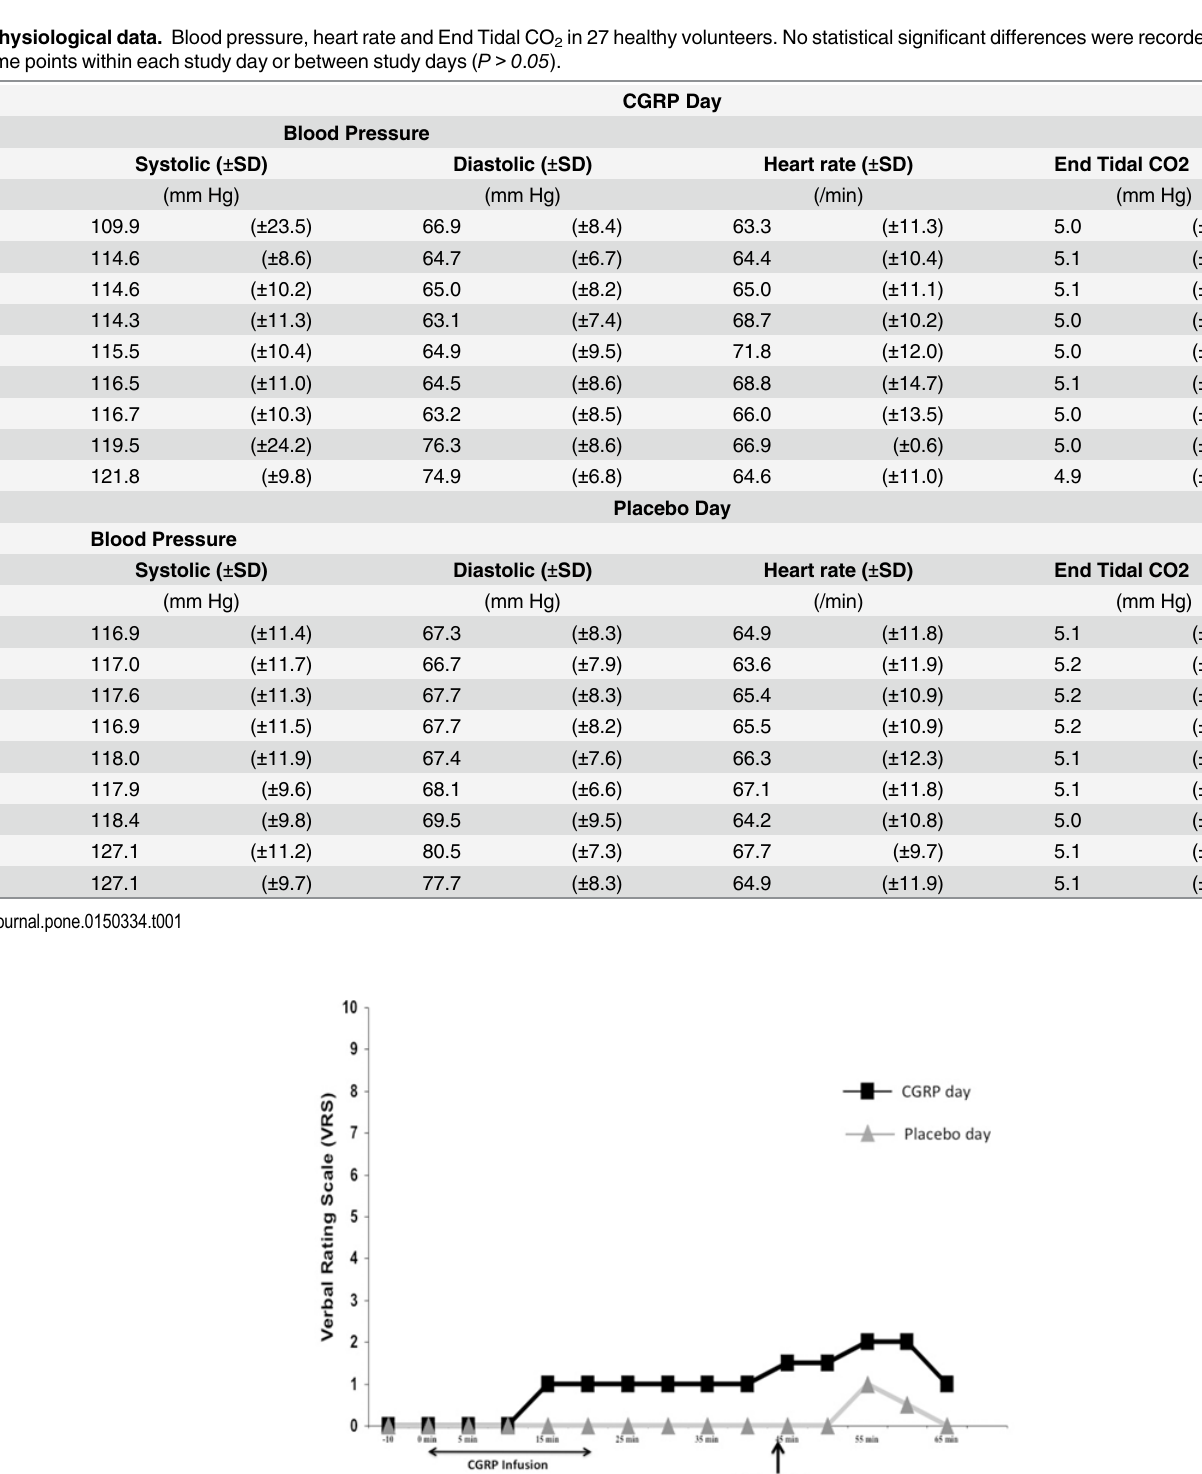
Table 1. Physiological data. Blood pressure, heart rate and End Tidal CO 2 in 27 healthy volunteers. No statistical significant differences were recorded between time points within each study day or between study days ( P > 0 . 05 ).